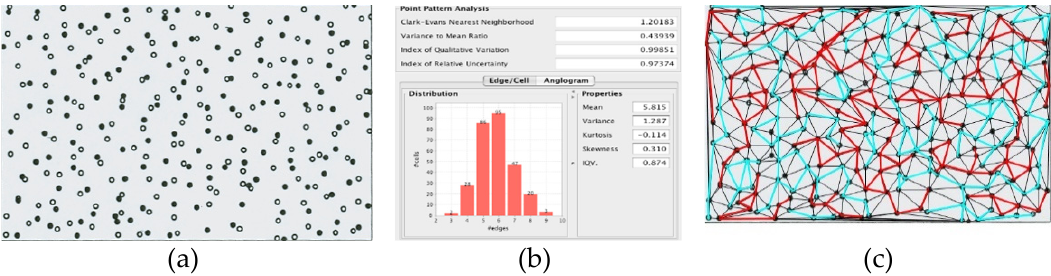
(c) Figure 8. ( a ) Observed distribution of amacrine cells. ( b ) Ka-me screenshot of the distribution of Voronoi polygons generated by using each amacrine cell as a generator point. ( c ) A colored Delau- nay triangulation of neighboring amacrine cells. There are three kinds of edges depending upon the corresponding states of neighboring amacrine cells: on-on, off-off, and on-off. In this case, we can test the distribution of the three kinds of edges with a Chi-squared test for bivariate data if we presume a binomial distribution. There were 294 observed amacrine cells, of these 152 were in the on state and 142 were in the off state. When we examine the Delaunay edges in Figure 5c we found a total of 840 edges,